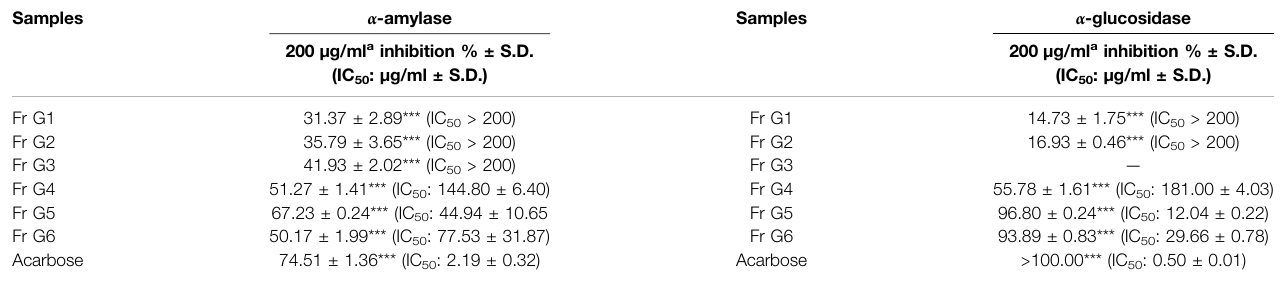
TABLE 4 | Enzyme inhibitory activity results of the fractions from RP-18 column chromatography of Fr G. Samples α -amylase Samples α